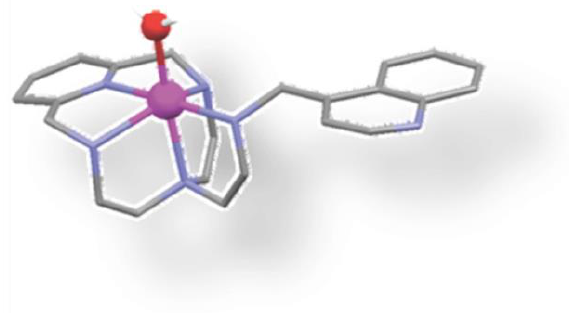
Figure 9. Stick and ball structure of Pytren4Q-Mn (Mn-L1). In red oxygen, pink manganese and blue nitrogen [72].